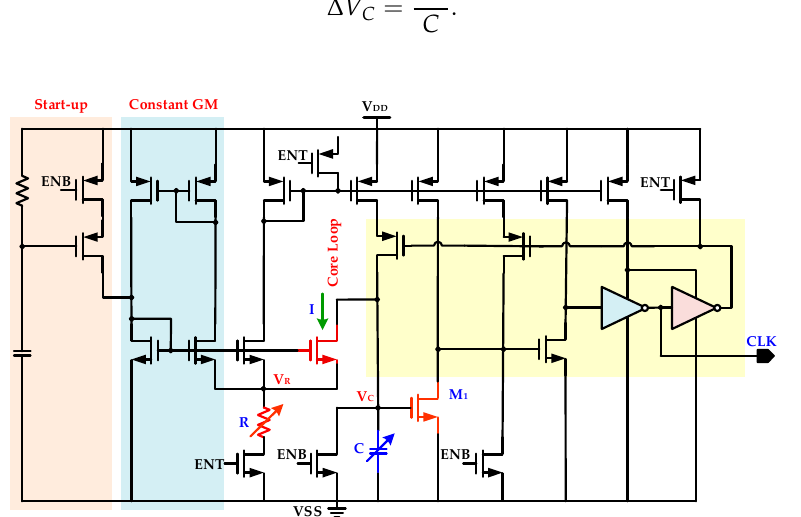
Figure 9. Ultra-low power configurable range communication (RC) oscillator.